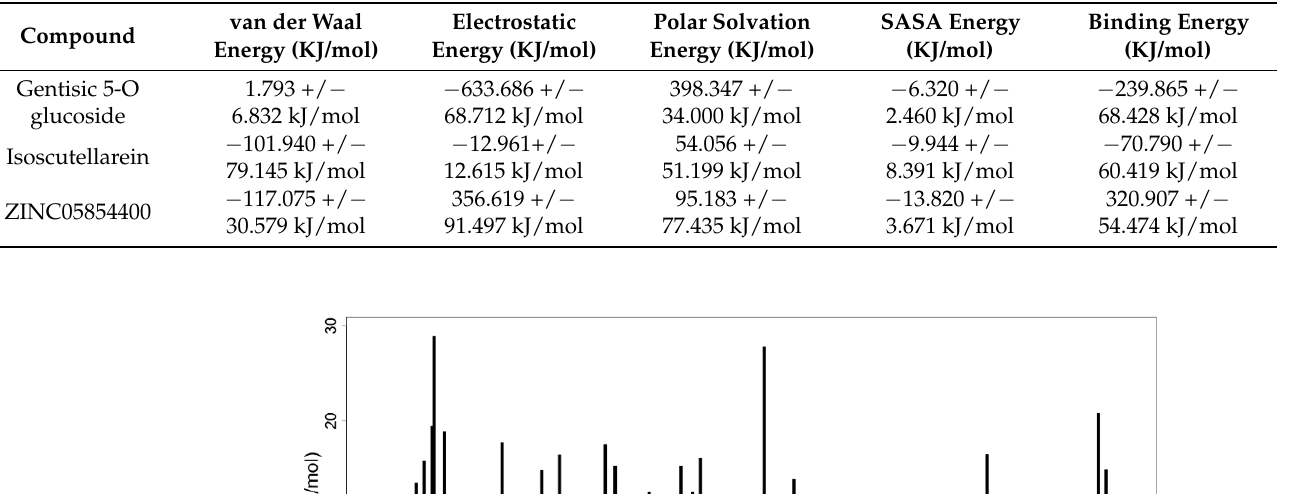
Table 6. Energy terms of the CGS–ligand complexes from MM-PBSA calculation. The values are presented in average ± standard deviations in kJ/mol.